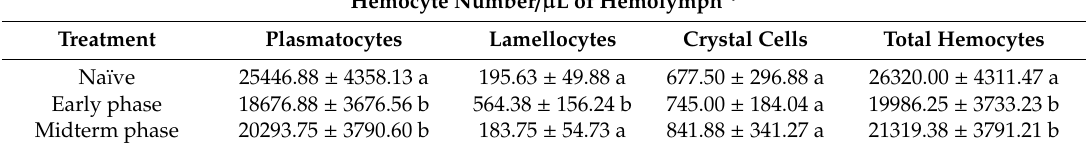
Table 1. * Evaluation of hemocytes population (mean ± SD) of total and di ff erential count of three D. suzukii larvae treatments: naïve larvae (no infected), early phase of infection (with only nematode presence) and midterm phase of infection (nematode and bacterial presence). Di ff erent letters indicate statistically significant di ff erences among treatments for each cell type ( p < 0.05).